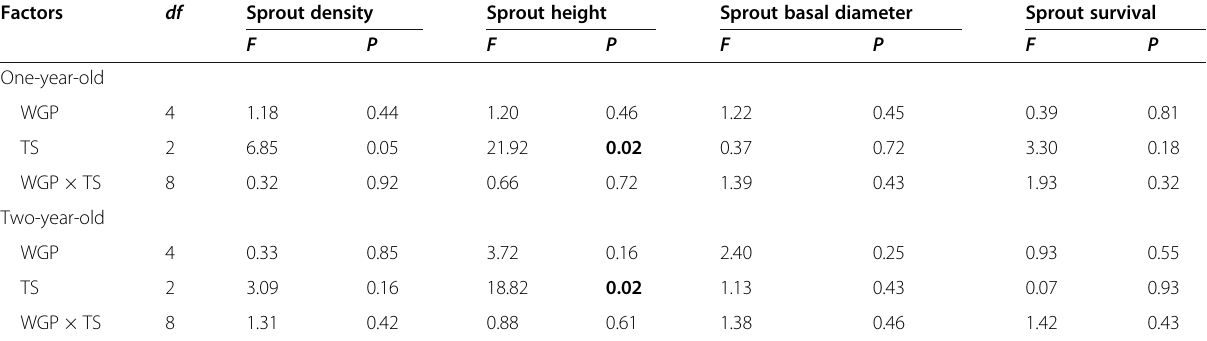
Table 4 Effects of within-gap position and tree species on the sprout density, growth, and survival of 1-year-old and 2-year-old sprouts